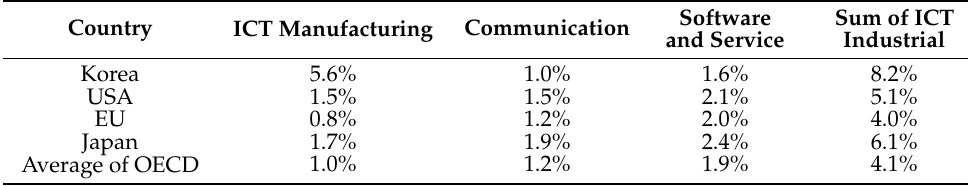
Table 1. Share of added value to GDP in the ICT industry (2015). Country ICT Manufacturing Communication